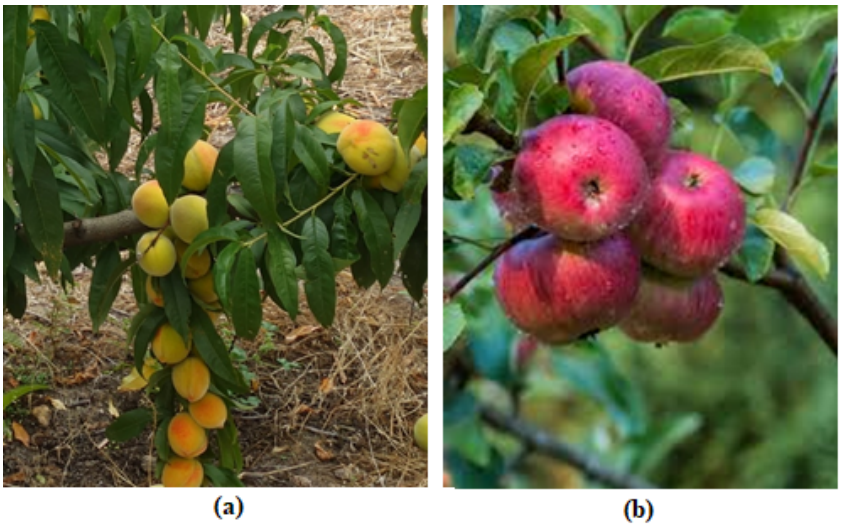
Figure 1. Particularity of fruit type: ( a ) peach. ( b ) apple. Bargoti and Underwood [9] presented a methodology to obtain an estimate of red and green apples. For the detection phase, they used the traditional computer vision approach based on hue, saturation, and value (HSV) color space for segmentation. With the development of convolutional neural networks (CNNs), many authors use them for fruit detection based on segmentation and object detection approaches. Puttemans et al. [10] proposed a watershed and trinocular stereo triangulation-based segmentation with a cascade of weak classifiers to perform a strawberry and apple detector model.